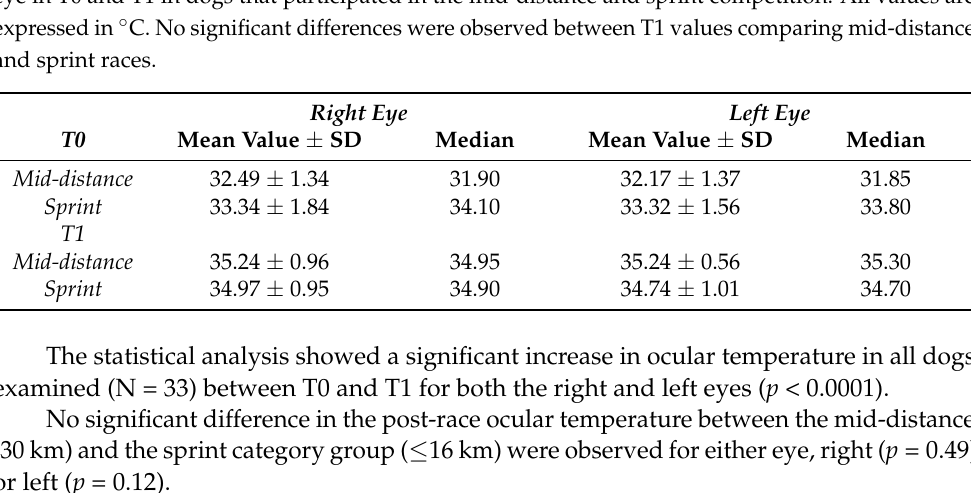
Table 4. Mean ± SD and median temperature values of the ROIs in T0 and T1.